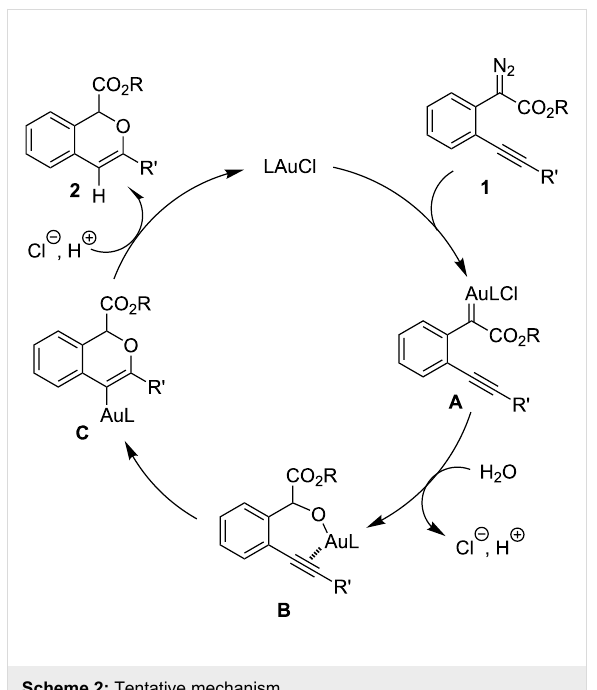
Scheme 2: Tentative